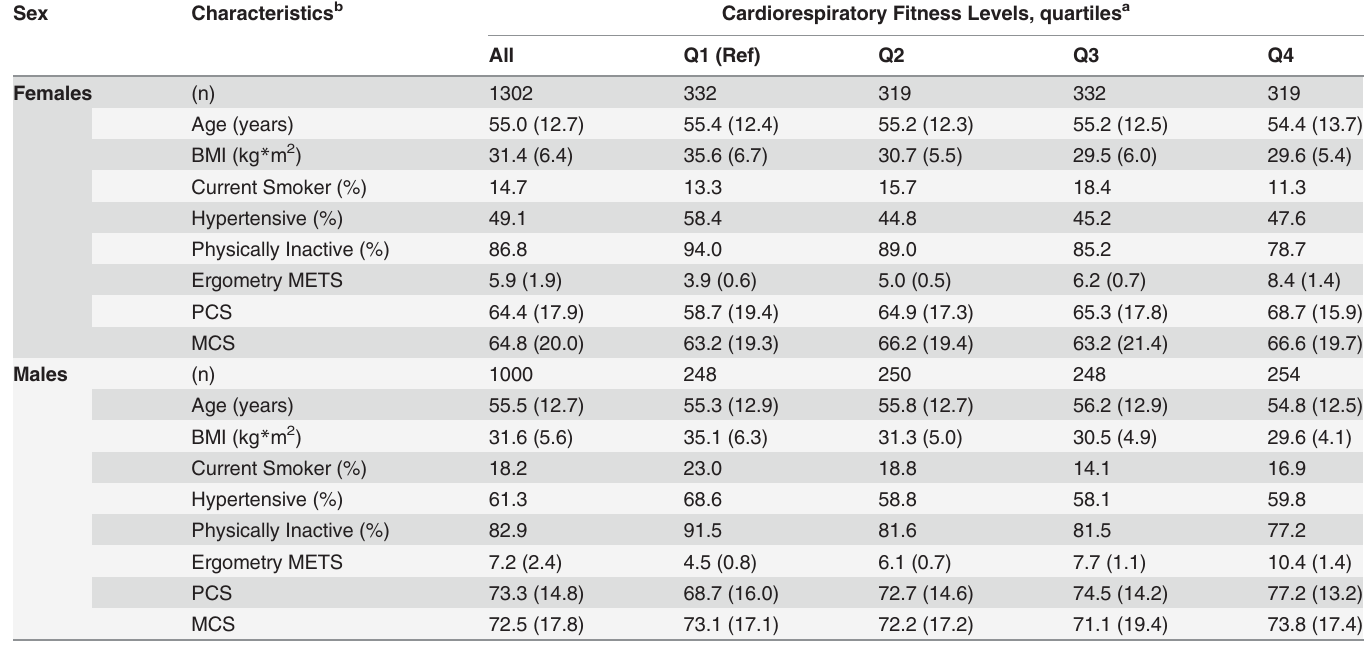
Table 1. Participant demographic characteristics by gender and cardiorespiratory fitness level. Sex Characteristics